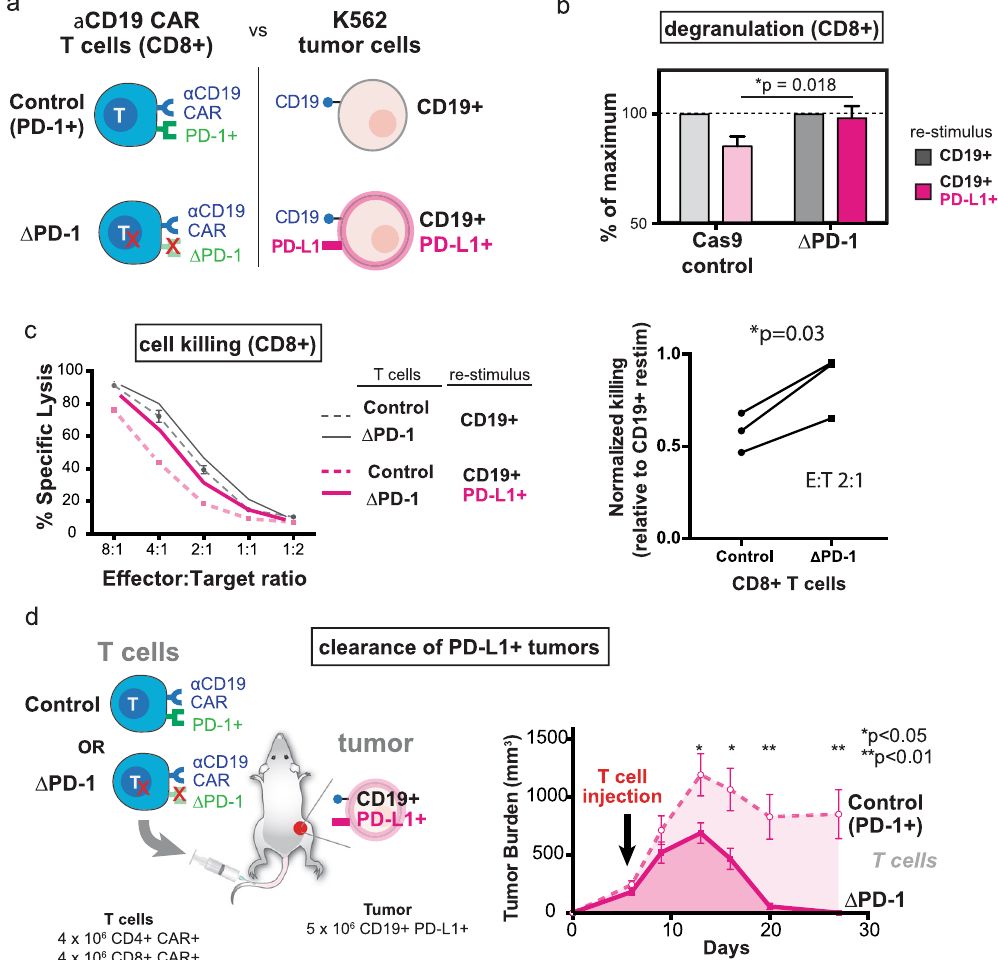
Figure 3. CRISPR-mediated PD-1 editing rescues anti-CD19 CAR T cell function in vitro and enhances tumor clearance in vivo . ( a ) Diagram of PD-1 edited CAR T cell: K562 interactions ( b ) PD-1 edited CD8 + anti-CD19 CAR T cells ( Δ PD-1) exhibit greater degranulation (CD107a staining) upon co-culture with CD19 + PD-L1 + K562 cells as compared to control CD8 + CAR T cells ( * p = 0.018, Student’s t-test). ( c ) PD-1 edited CAR T cells are partially resistant to CD19 + PD-L1 + mediated inhibition of cytolysis. Left panel: percent lysis for control and PD-1 edited CD8 + anti-CD19 CAR T cells is shown across a range of effector:target ratios. Error bars are S.D. of triplicate wells in a single experiment. Right panel: normalized killing shows reduced PD-L1 dependent inhibition of killing in PD-1 edited CD8 + CAR T cells at effector:target ratio of 2:1 ( * p = 0.03, paired t-test). The experiment was performed three independent times. ( d ) PD-1 deficient anti-CD19 CAR T cells exhibit enhanced anti-tumor efficacy and clear subcutaneous CD19 + PD-L1 + tumor xenografts. NSG mice were injected with 5 × 10 6 CD19 + PD-L1 + K562 cells subcutaneously. Mice with established tumors (100–250 mm 3 ) were injected intravenously with 4 × 10 6 CD4 + CAR + and 4 × 10 6 CD8 + CAR + control T cells or PD-1 edited cells, and tumor burden measured longitudinally by caliper. Tumor burdens are mean ± SEM for each group (n = 6 mice per group). A statistically significant decrease in tumor burden of mice receiving PD-1 edited CAR T cells was observed at multiple points ( * p < 0.05, ** p < 0.01, Student’s